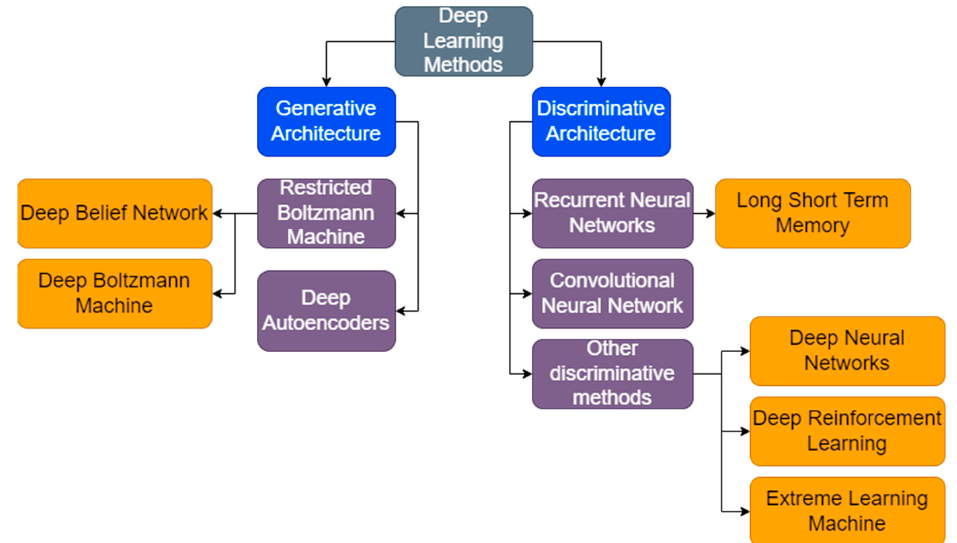
Figure 8. Current deep learning models for skin cancer diagnosis: tree illustration.